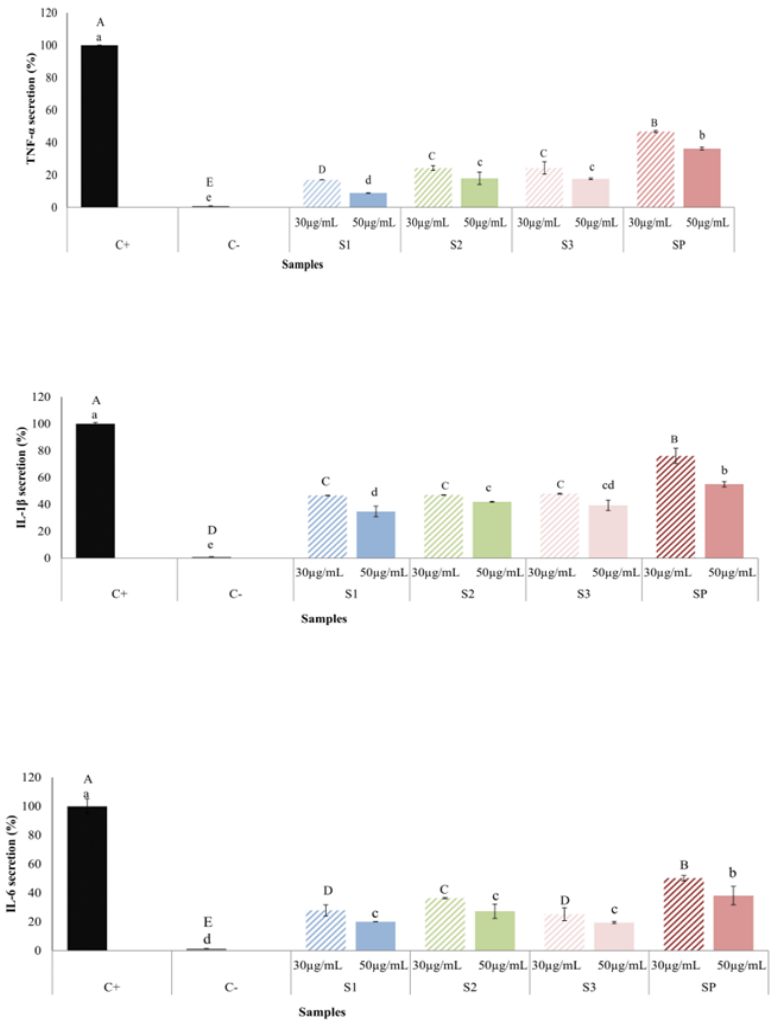
Figure 6. Levels of TNF- α , IL-1 β , and IL-6 secreted by THP-1/M activated with LPS, in the presence of 30 or 50 µg/mL of MB SFE extracts for 24 h. Positive control (C+), LPS-stimulated cells. Negative control (C − ), not LPS-stimulated cells. Each bar is the mean of three determinations ± S.D. Capital letters A, B, C, D and E show statistical differences between among miracle berry samples S1, S2, S3 and SP at 30 µg/mL, C+ and C − . Letters in lower case a, b, c, d and e show statistical differences among miracle berry samples S1,S2, S3 and PS at 50 µg/mL, compared to C+ and C − . Significance level at p < 0.05 according to Fisher’s least signi fi cant di ff erence (LSD) test.